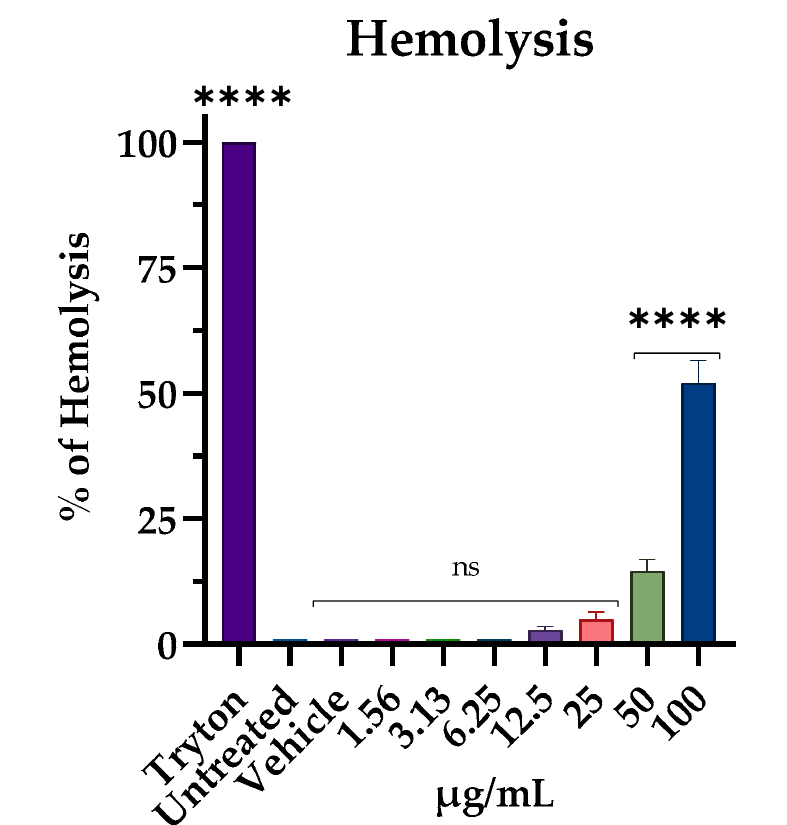
Figure 9. The ability of M15RL to interfere with mammalian cells. Thus, the cytotoxicity was assessed by hemolysis assay. Statistical analyses were determined by ANOVA with Dunnett’s test for multiple comparisons. Significances are referred to the untreated red cells. **** p < 0.0001, ns (not statistically significant).